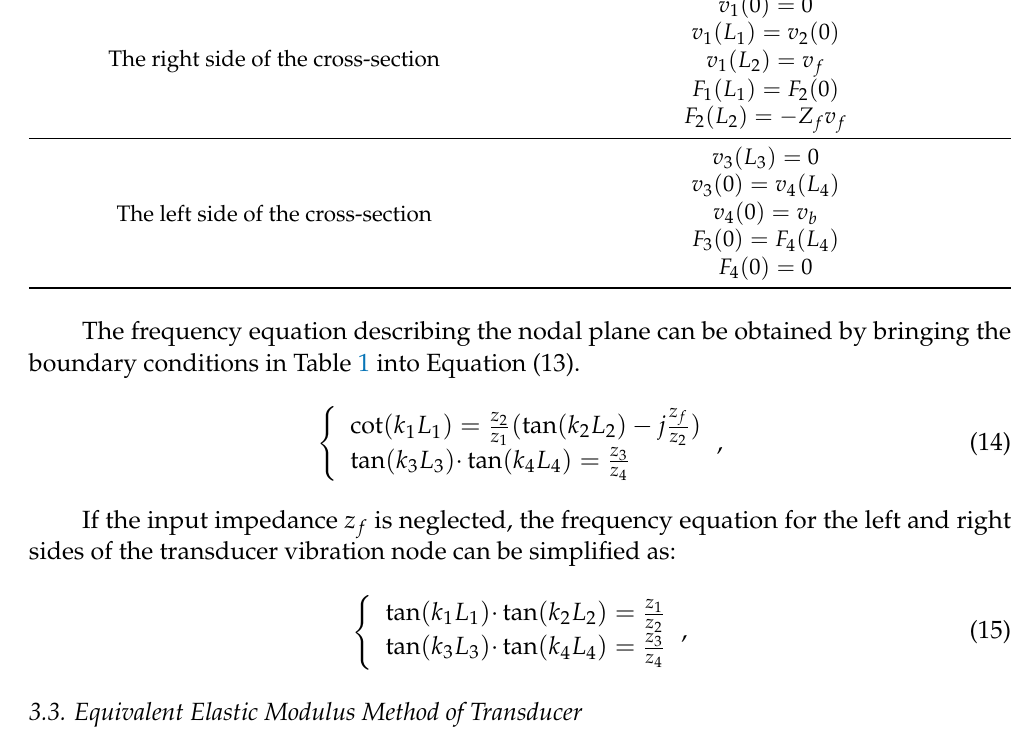
Table 1. Boundary conditions of transducer vibration node’s sections. Cross-Sectional Position Boundary Conditions